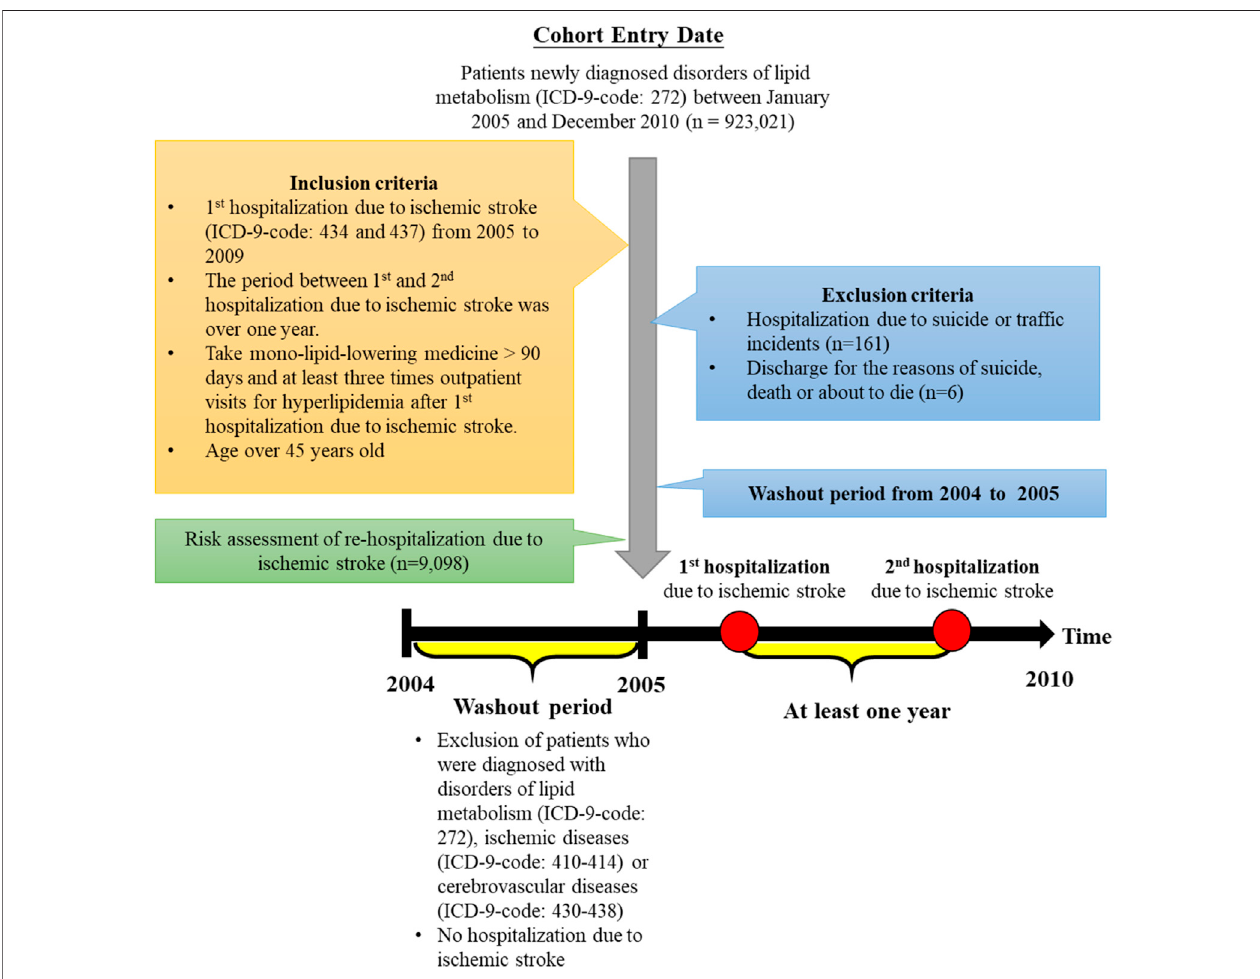
FIGURE 1 | Study work fl